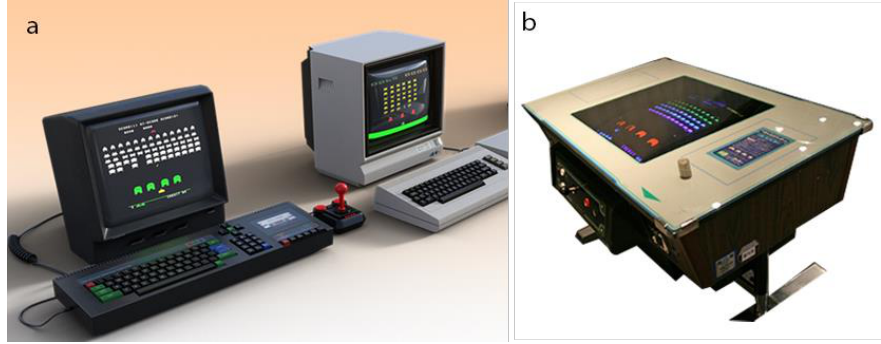
Figure 4. Space invaders game: ( a ) computer old retro version; ( b ) table-top version game.